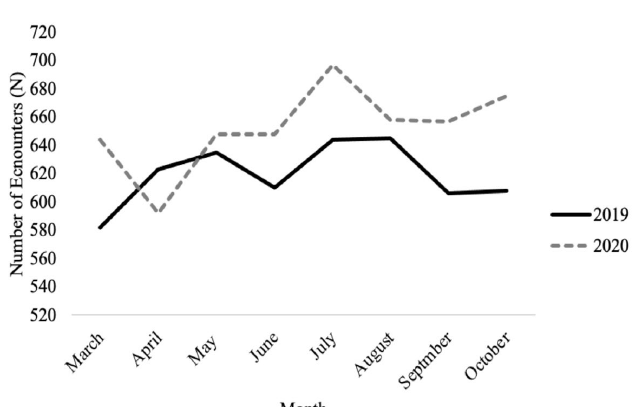
Figure 1. Charlotte-Mecklenburg Police Department encounters for intimate partner violence-related assaults from 2019-2020.